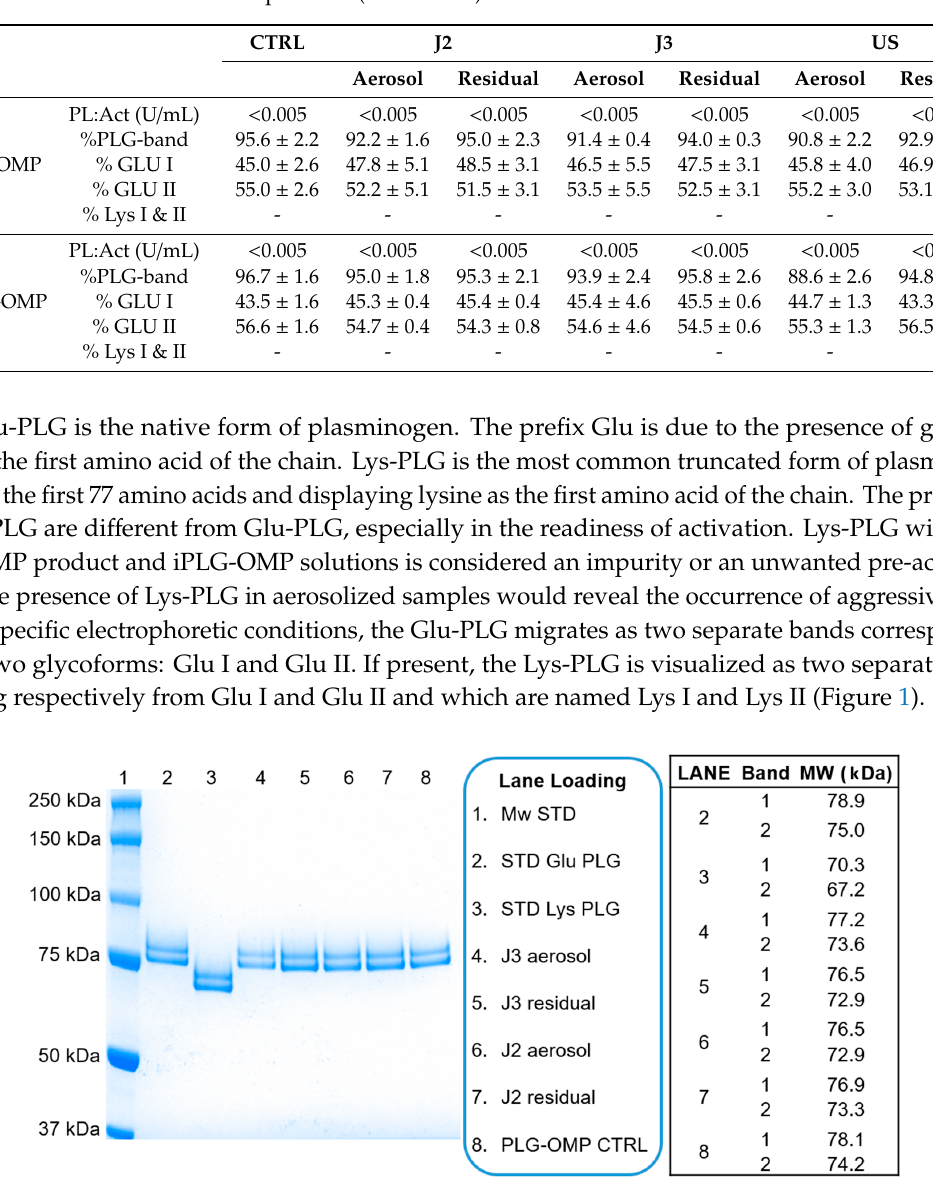
Table 2. Biochemical characterization of PLG-OMP and iPLG-OMP solutions before (CTRL) and after aerosolization under the three nebulization settings: jet nebulizations (J2 and J3) and ultrasonic nebulization (US); both aerosol and ampoule residual solutions are displayed. All values are reported as the mean of at least three repetitions (mean ± SD).